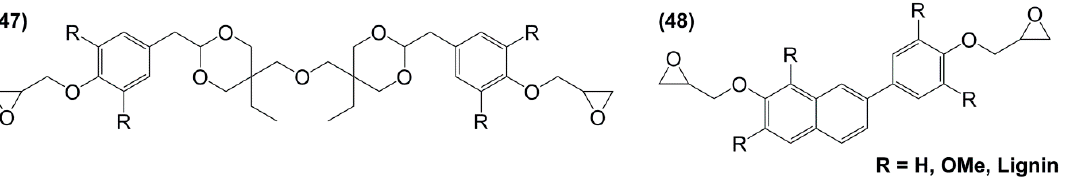
Figure 28. Lignin-based epoxy resins synthesized by Kaiho et al. [189].